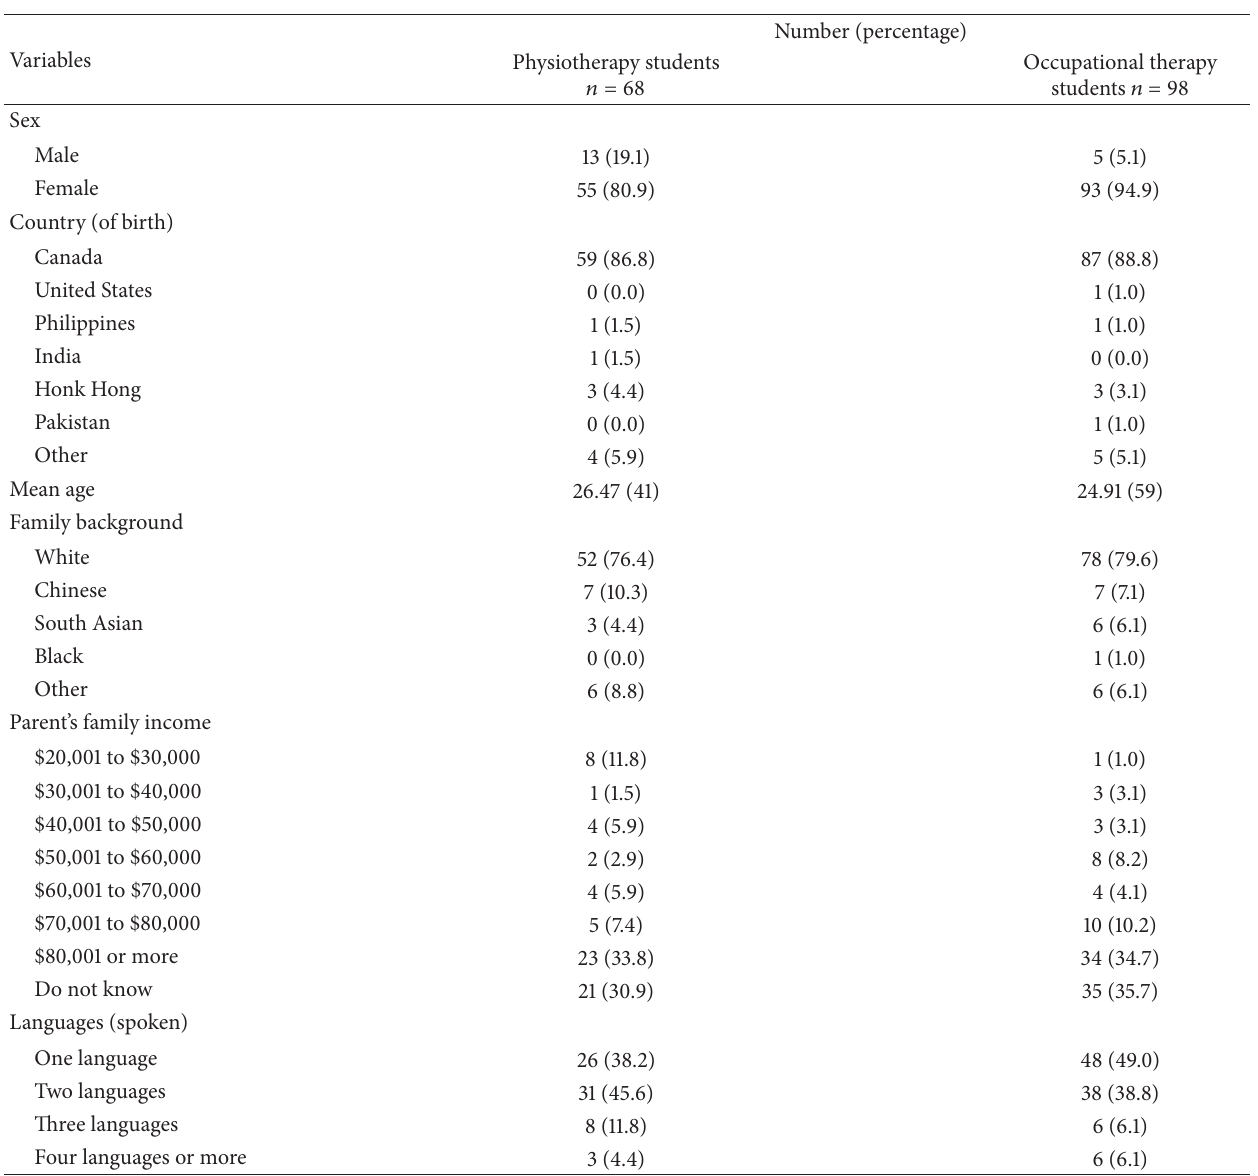
Table 1: Demographic characteristics of respondents ( 𝑁 = 166